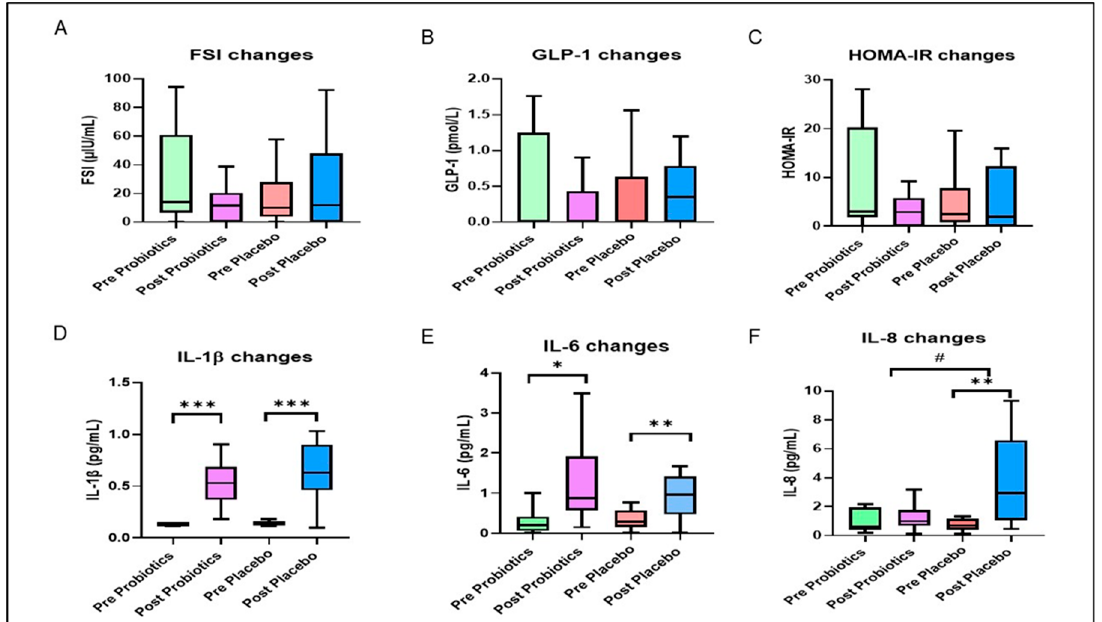
Figure 3. Changes in glycemic and inflammatory outcomes during the 12-week intervention. The box represents the interquartile range (IQR), the inside line represents the median, and the whisker represents the maximum and minimum value. ( A ) Fasting serum insulin (FSI) changes, ( B ) active glucagon-like peptide-1 (GLP-1) changes, ( C ) homeostasis model assessment of insulin resistance (HOMA-IR) changes, ( D ) interleukin-1 β (IL-1 β changes), ( E ) interlukin-6 (IL-6) changes, ( F ) interleukin-8 (IL-8) changes. * Significant difference within the group. * p -value < 0.05, ** p -value < 0.01, and *** p -value < 0.001 were considered statistically significant. # Significant difference between the two groups. Changes in Inflammatory Outcomes.